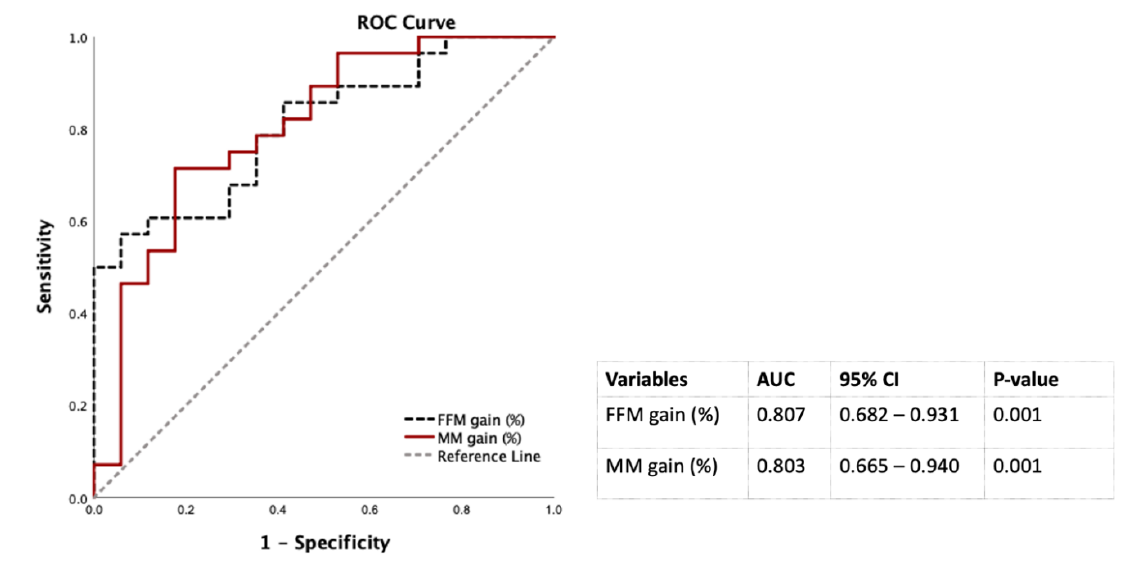
Figure 3. Discrimination power of percentages of FM loss and SM gain 12 months post-LSG using the ROC curves for males. Abbreviation: AUC: area under the ROC curve; CI: confidence interval; FFM: fat-free mass; LSG: laparoscopic sleeve gastrectomy; ROC: receiver operating characteristic; SM: skeletal muscle mass.